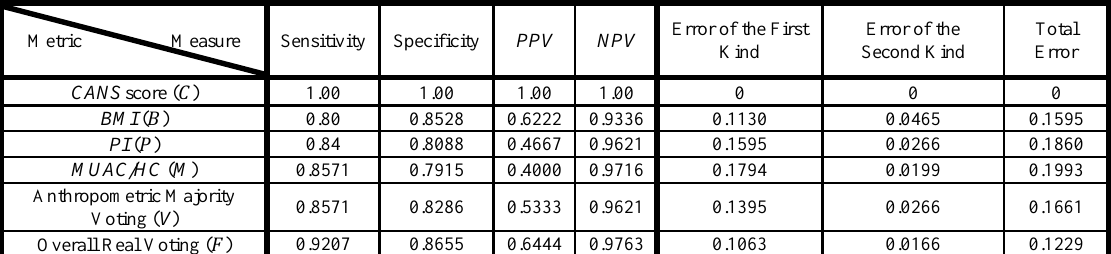
Table 2. Various direct and reverse measures of the CANS score ( 𝐶 ) with respect to different metrics (including 𝐶 itself), wherein each measure might be multiplied by 100 to express a percentage Metric Measure Sensitivity Specificity PPV NPV